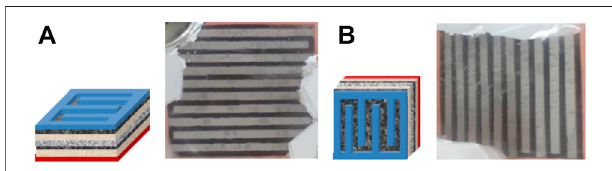
FIGURE 3 | Schematics and photographs depicting two-phase fl ow in cathode channels of (A) a supine cell (cathode up) and (B) a standing cell (vertical channel) at a cell voltage of 3.0 V.